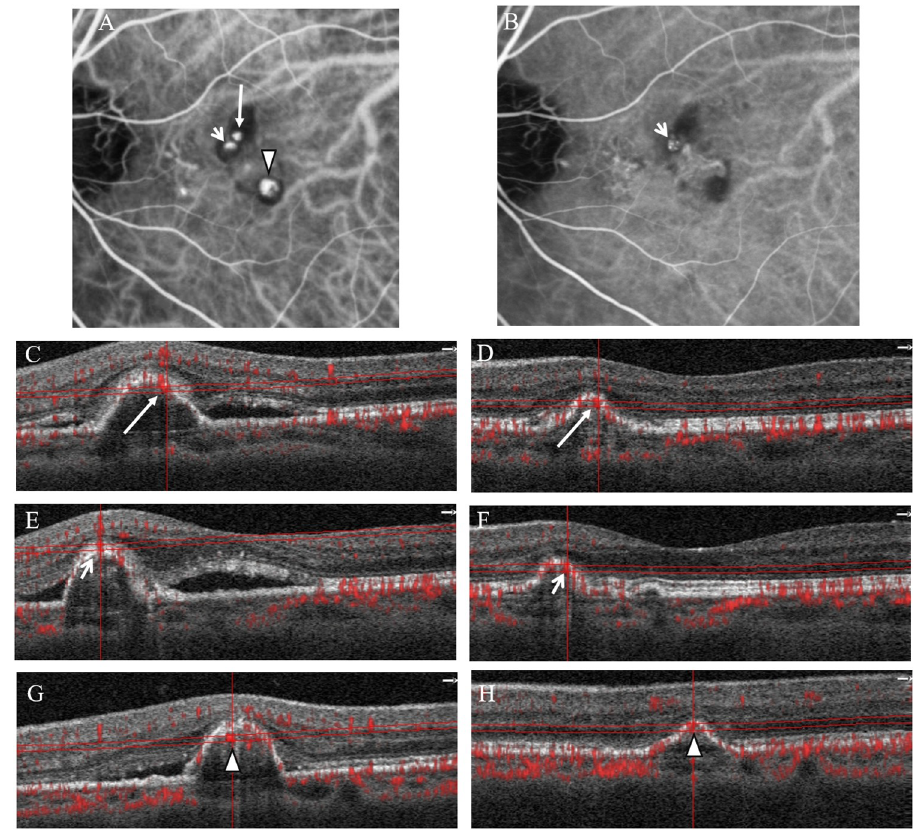
Fig 3. ICGA and OCTA of case 1. (A) ICGA before treatment showed 3 polyps, labeled as polyp 1 (long arrow), polyp 2 (short arrow), and polyp 3 (arrowhead). (B) ICGA after treatment showed complete regression of polyp 1 and 3, but partial regression in the size of polyp 2 (short arrow). (C) OCTA of polyp 1 before and (D) after treatment showed the presence of flow signal (long arrow). (E) OCTA of polyp 2 before and (F) after treatment showed the presence of flow signal (short arrow). (G) OCTA of polyp 3 before and (H) after treatment showed the presence of flow signal (arrowhead). Polyps regression as a treatment goal for PCV management remained controversial since recent clinical trials had shown improved visual acuity with inactive but persisted polyps [18, 22]. A recent study with up to 11 years of follow-up showed that the long-term risk for massive submacular hemorrhage was significantly higher in patients with persistent polyps than those without [23]. The 2 years EVEREST II and the 2 years PLANET studies reported that the per- centage of complete polyp regression as assessed by ICGA was around 34.7% after intravitreal injections of ranibizumab and 38.9% after aflibercept monotherapy at 12 months [18, 22]. The number of injections in the monotherapy arm ranged from 3 to 12, indicating that a high vari- ety of polyps responded to anti-VEGF treatment. Even with combination therapy, 30% of the polyps remained present at 12 months [18]. Although several studies reported that single pol- yps, a smaller polyp area, and non-cluster type polyps had a better response after anti-VEGF monotherapy [19–21], it remained unknown whether the flow rate played a role in the treat- ment response. Our study showed that flow signal in OCTA, which may be attributed to the blood flow rate from the choroid to the polyps [12], could be a possible reason for the variable response to anti-VEGF treatment.